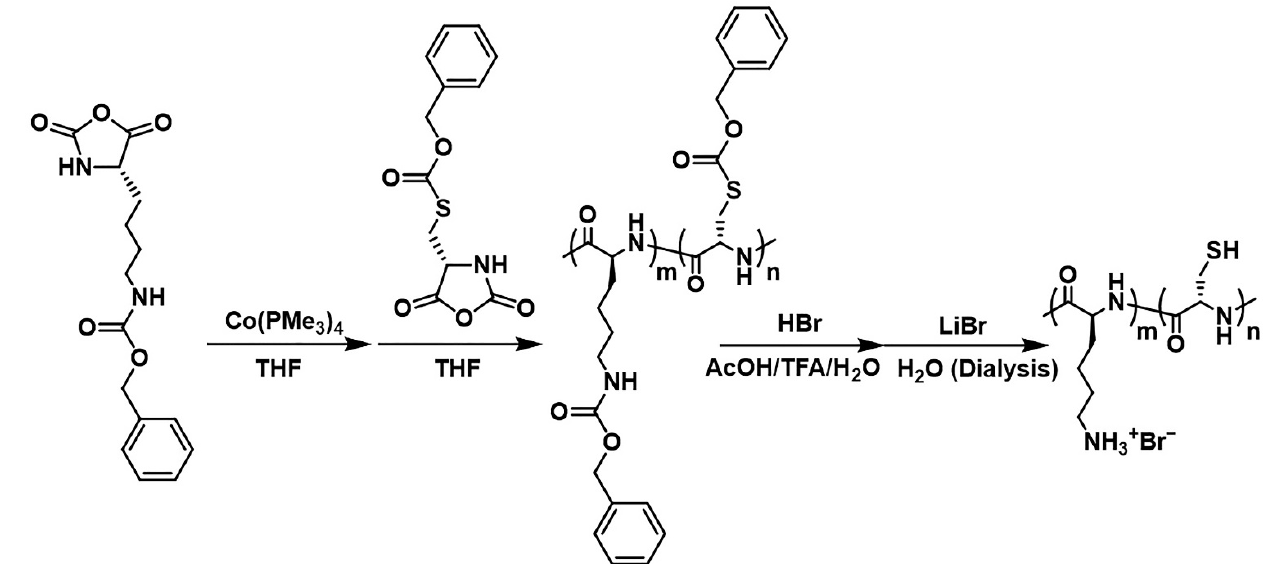
Figure 12. Synthetic scheme of diblock copolypeptide amphiphiles 1–3. Table 4. Properties of the diblock copolypeptide amphiphiles synthesized in this work.